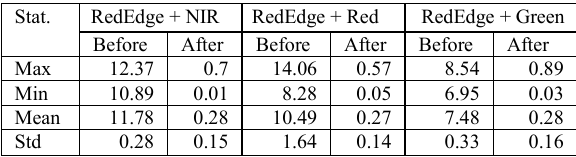
Table 6. Image point pair distances before and after registration On the other hand, misregistration of compositely processed orthophotos is at a minimal average of 0.3 pixels. This can be attributed to corrections during image level co-registration, triangulation, georeferencing, and orthorectification.